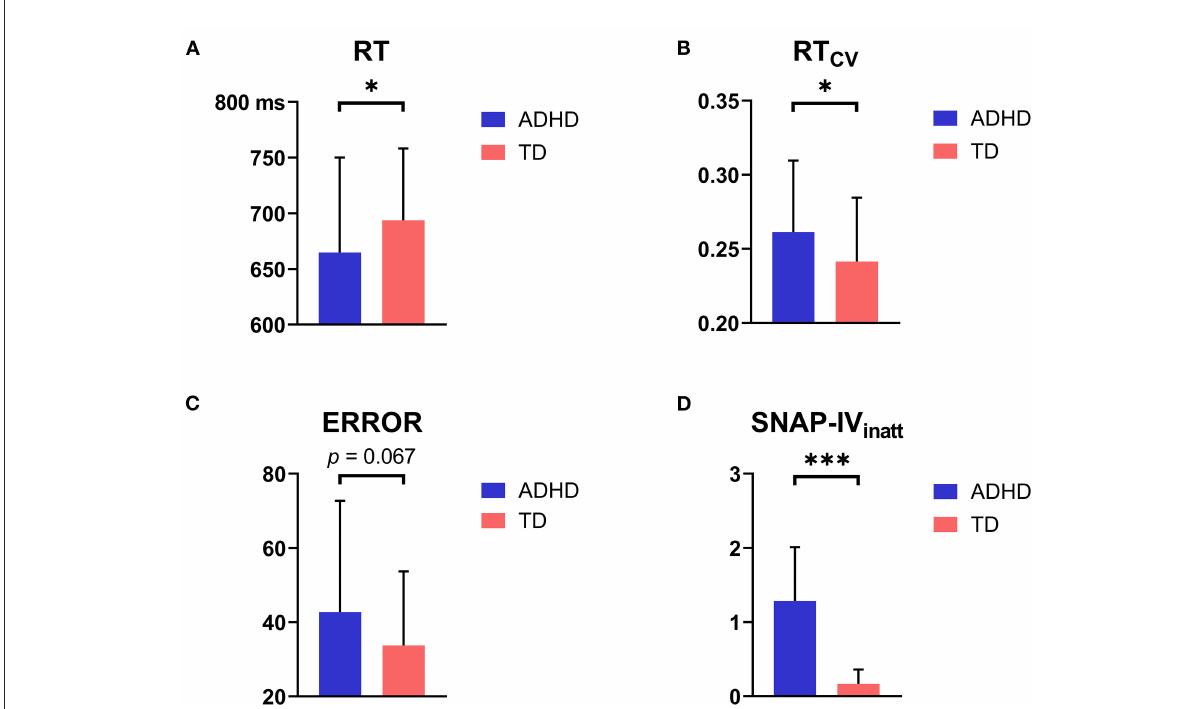
FIGURE4 Group differences in behavioral and clinical results. (A) Children with ADHD had significantly shorter RT than TD children. (B) Children with ADHD had significantly higher RT CV than TD children. (C) Children with ADHD had marginally higher ERROR than TD children. (D) Children with ADHD had significantly more severe ADHD symptoms than TD children (represented by SNAP-IV inatt Score). * p < 0.05; *** p <